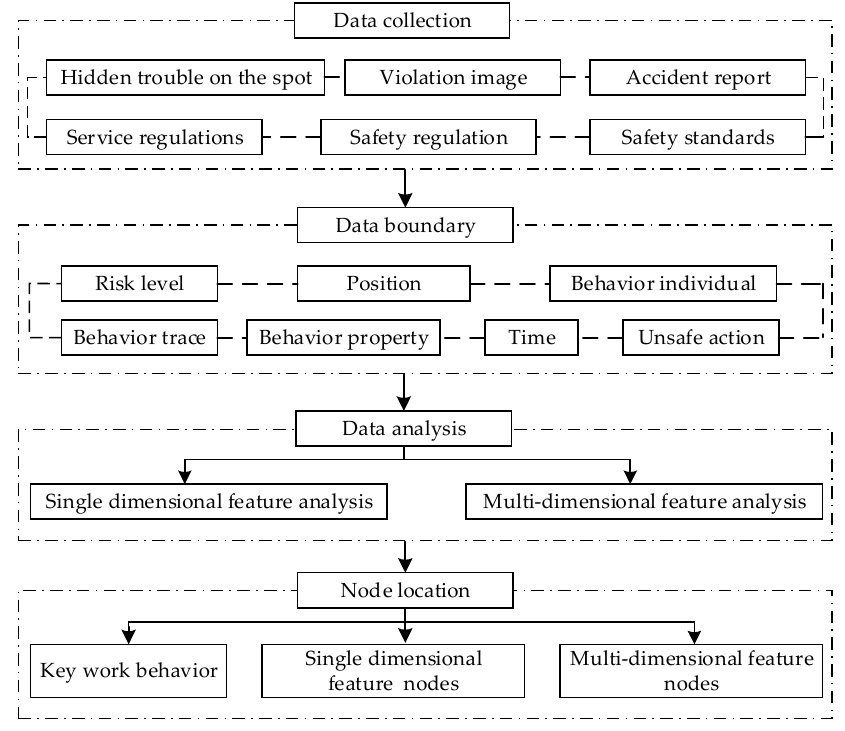
Figure 1 . Process of targeted intervention node locating. Figure 1. Process of targeted intervention node